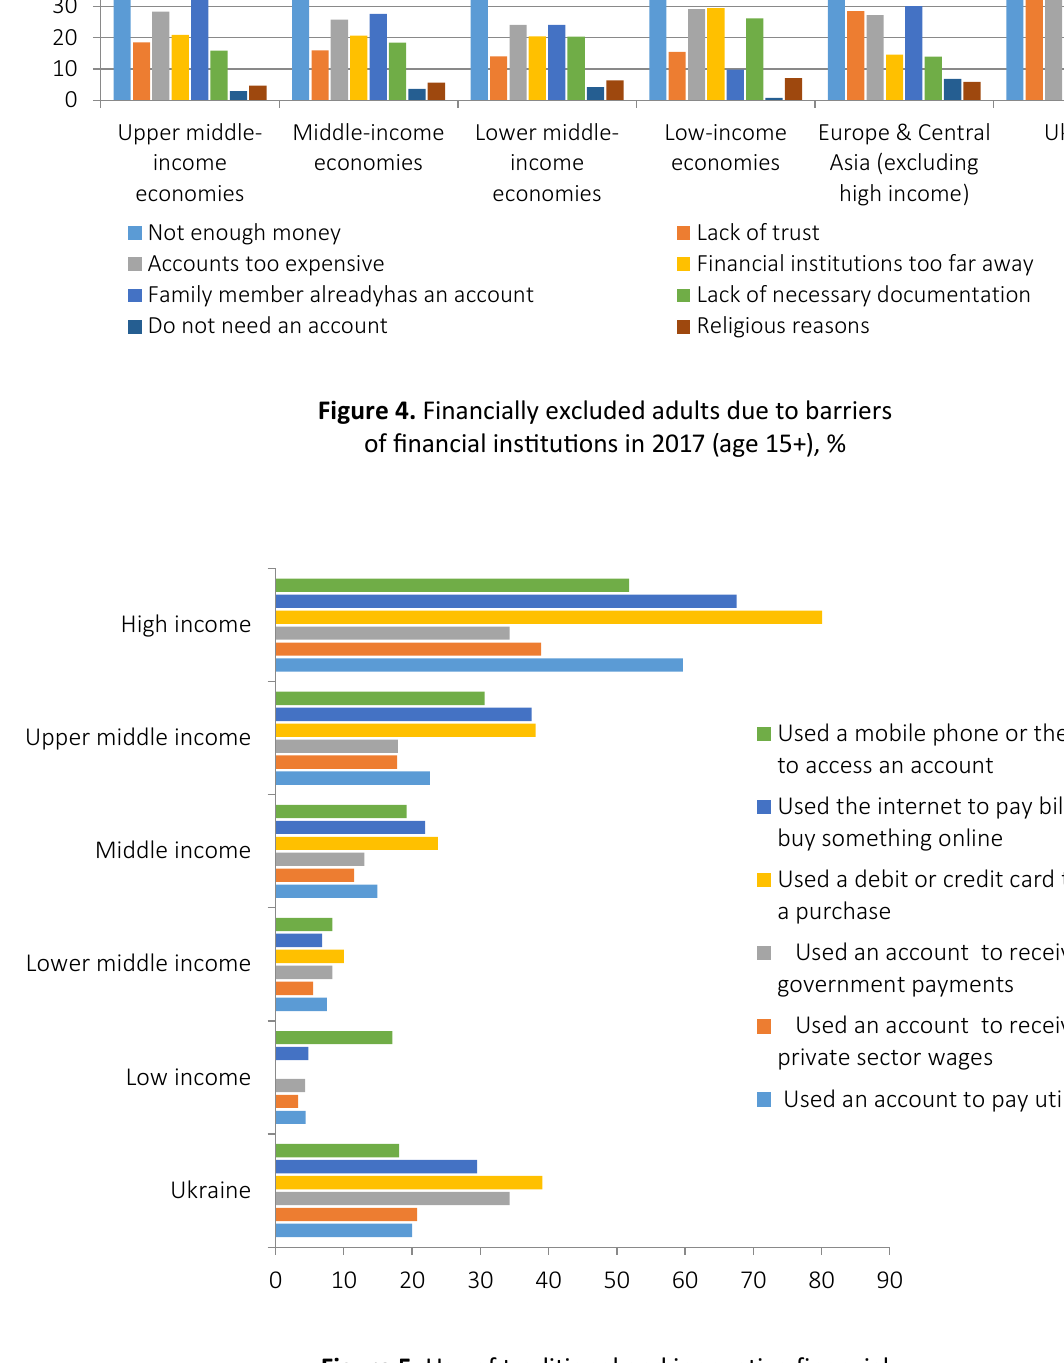
Figure 5. Use of traditional and innovative financial service channels for adults in Ukraine and other countries in